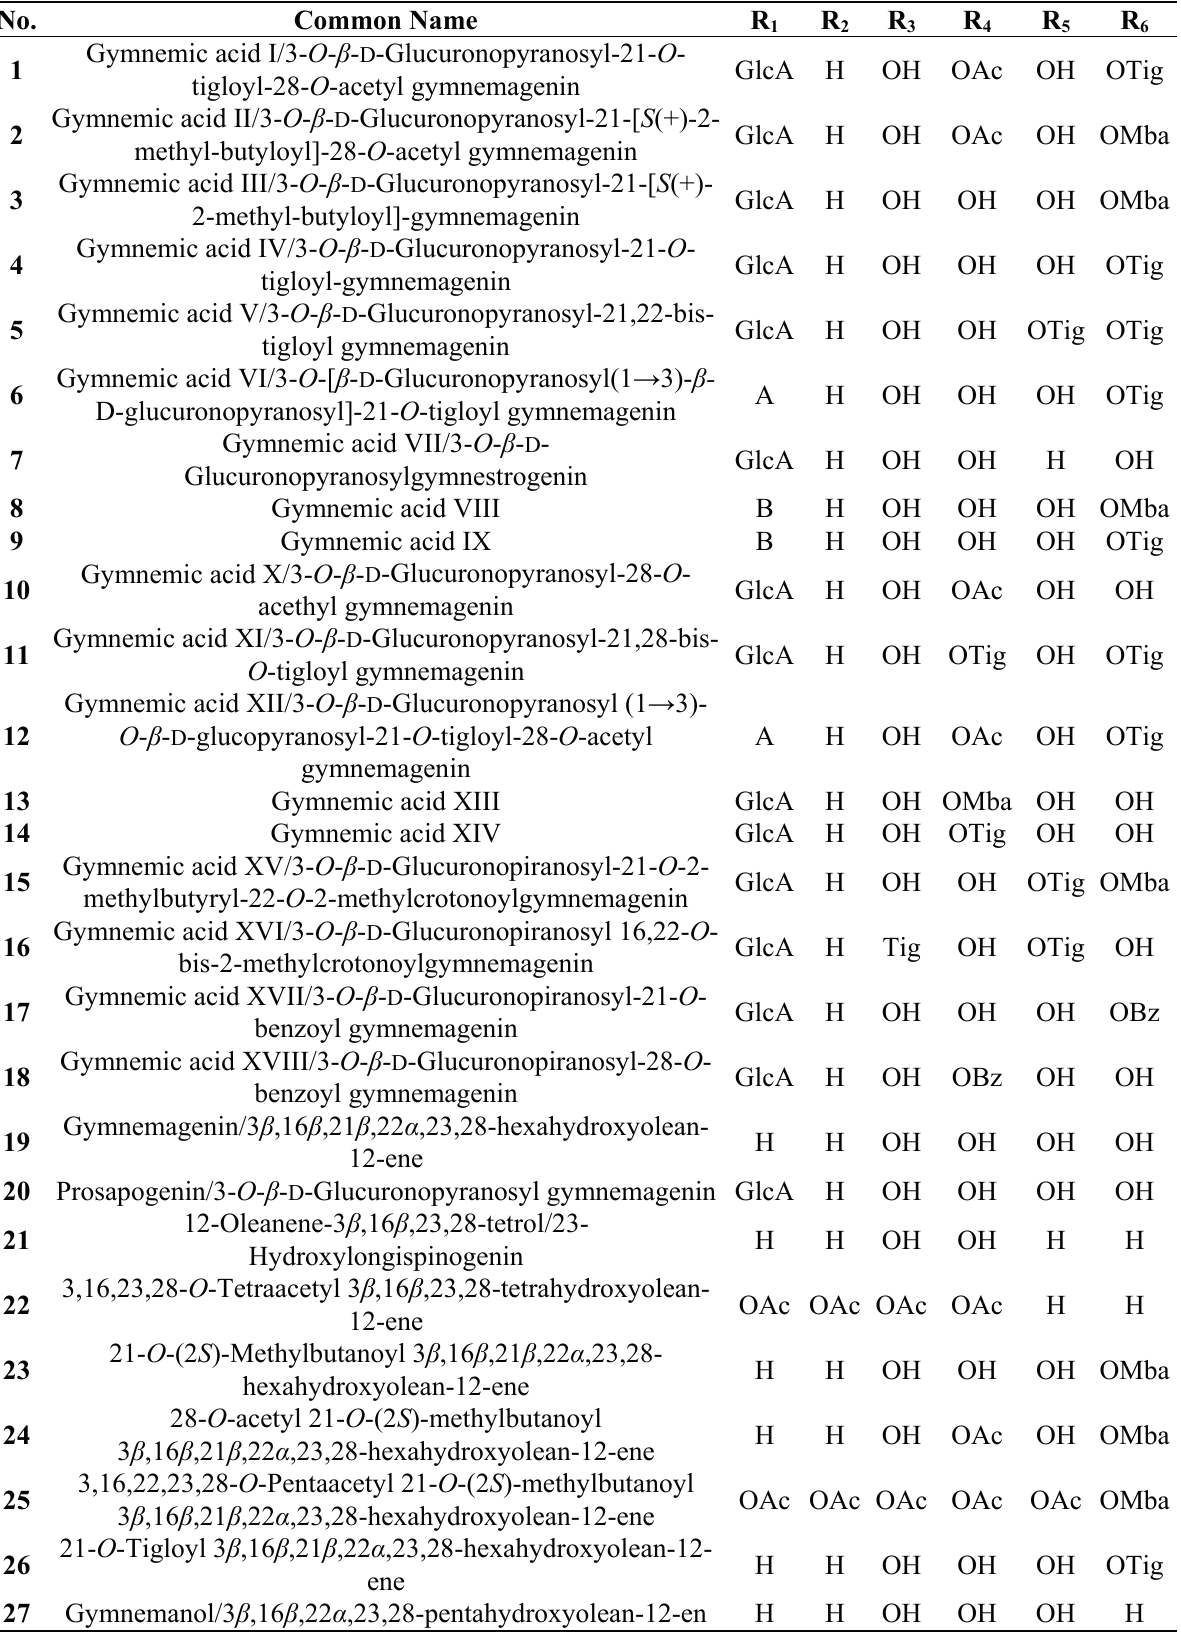
Table 1. Common name and relative substituents of triterpenes with olean-12-ene skeleton. No. 1